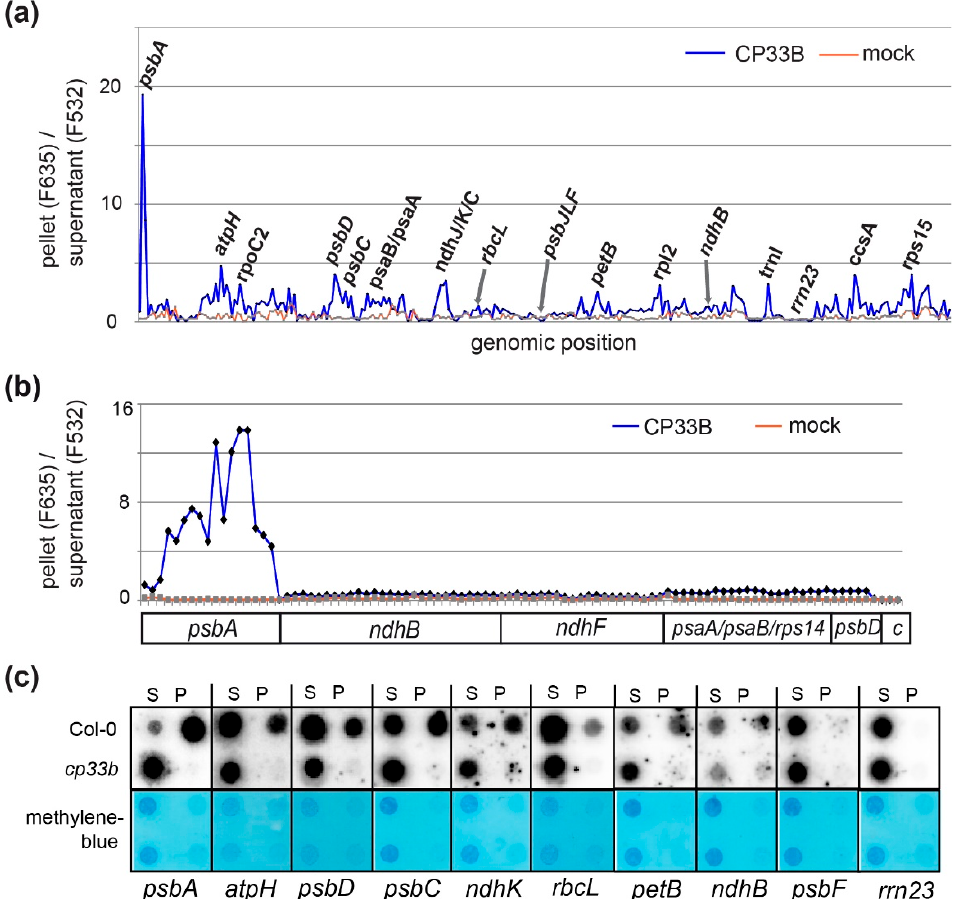
Figure 3. CP33B associated with multiple plastid transcripts, but foremost with the psbA mRNA. ( a ) RIP ‐ chip analysis of RNA co ‐ precipitated with CP33B using a microarray consisting of PCR products representing the entire Arabidopsis chloroplast genome with, on average, 1 kb fragments. Ratios of fluorescence signals from co-precipitated RNA (F635) and unbound RNA (F532) were plotted against the position on the chloroplast genome. Three biological replicates from CP33B immunoprecipitations and as control, two replicates of precipitations with the corresponding pre-immune serum and an IP on stroma of cp33b null mutants were performed. The precipitate / supernatant ratios (median of ratios) were normalized to the sum of the median values of the ribosomal RNAs of the supernatants (median F532; Table S1). Only selected peaks are labelled. ( b ) Oligonucleotide RIP-chip analysis for the interaction of CP33B with a selection of chloroplast transcripts. CP33B immunoprecipitations were performed from wild-type stroma with anti CP33B (four biological replicates) and as a control with the corresponding pre-immune serum (three biological replicates). Shown are the median of ratios of fluorescence signals from co-precipitated RNA (F635) and unbound RNA (F532; sequences of oligonucleotides and data in Table S2). Each plastid transcript, except for negative controls ( c ), is represented by several oligonucleotides (50 nt long; for a zoom-in see Figure S1). ( c ) The CP33B immunoprecipitations were performed on wild type stroma and cp33b null mutants. Equal volumes of isolated RNA from precipitate (P) and supernatant fraction (S) were transferred onto nylon membranes and hybridized with di ff erent radiolabeled RNA probes. The methylene blue staining of the nylon membranes reflects the total RNA content of each fraction. The analysis was repeated twice for psbA and once more for rbcL and rrn23, with similar results.